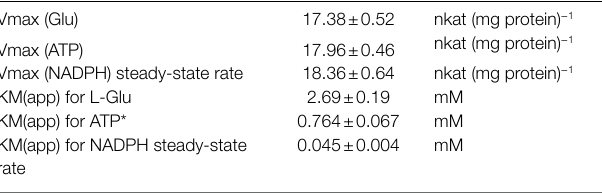
TABLE 1 | Kinetic properties of P5C synthetase 2 from